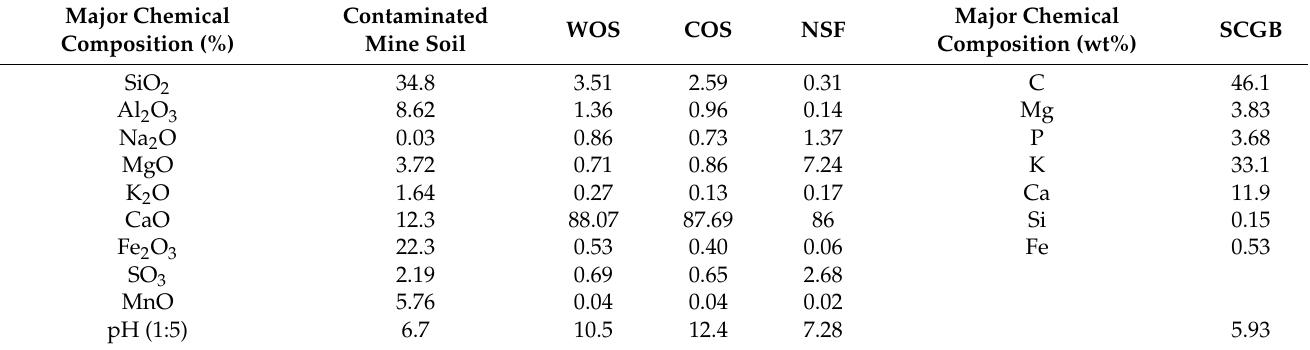
Table 2. Major chemical composition of contaminated mine soil, waste oyster shells (WOS),